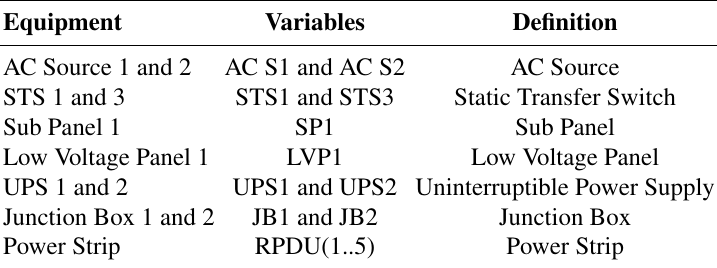
Table 3. Equipment, associated variables and